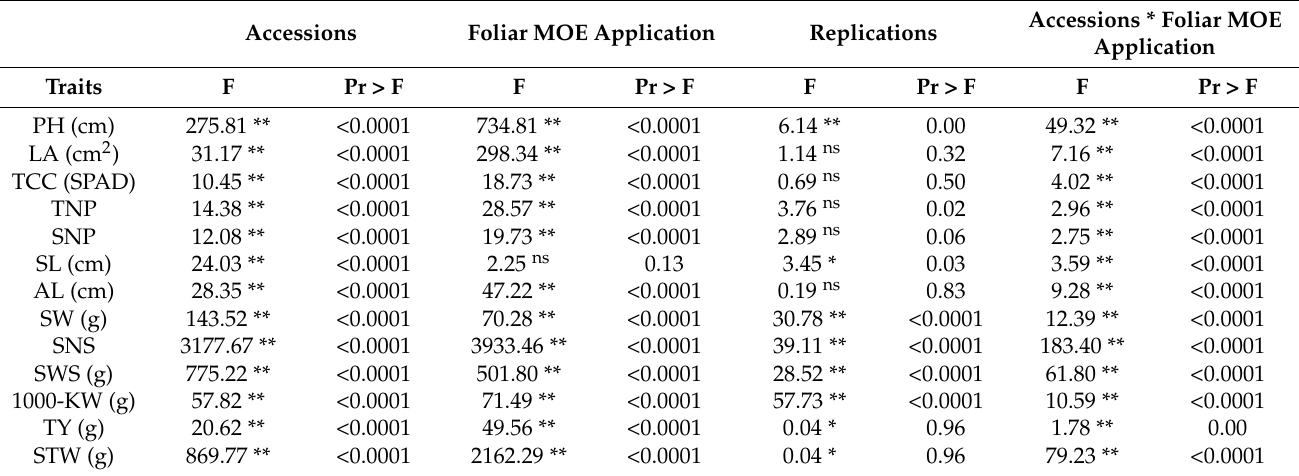
Table 2. Summary of analysis of variance of different studied traits.